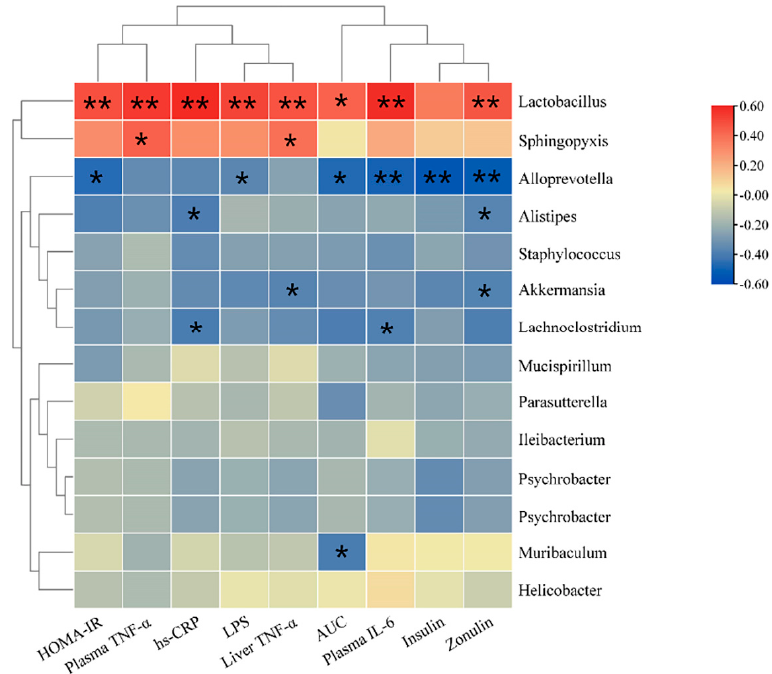
Figure 8. Heat map for correlations between biochemical indicators and gut microbiota. The X-axis and Y-axis of the heat map represent biochemical indicators and gut microbiota, respectively. The R and p values are calculated. The R values are expressed with different colors. The color card on the right side shows the color ranges of different R values. The “*” symbol indicates a significant correlation at the 0.05 level; ** indicates s significant correlation at the 0.01 level. The top clusters represent the clustering of biochemical indicators, and the left-side clusters represent the clustering of gut microbiota.